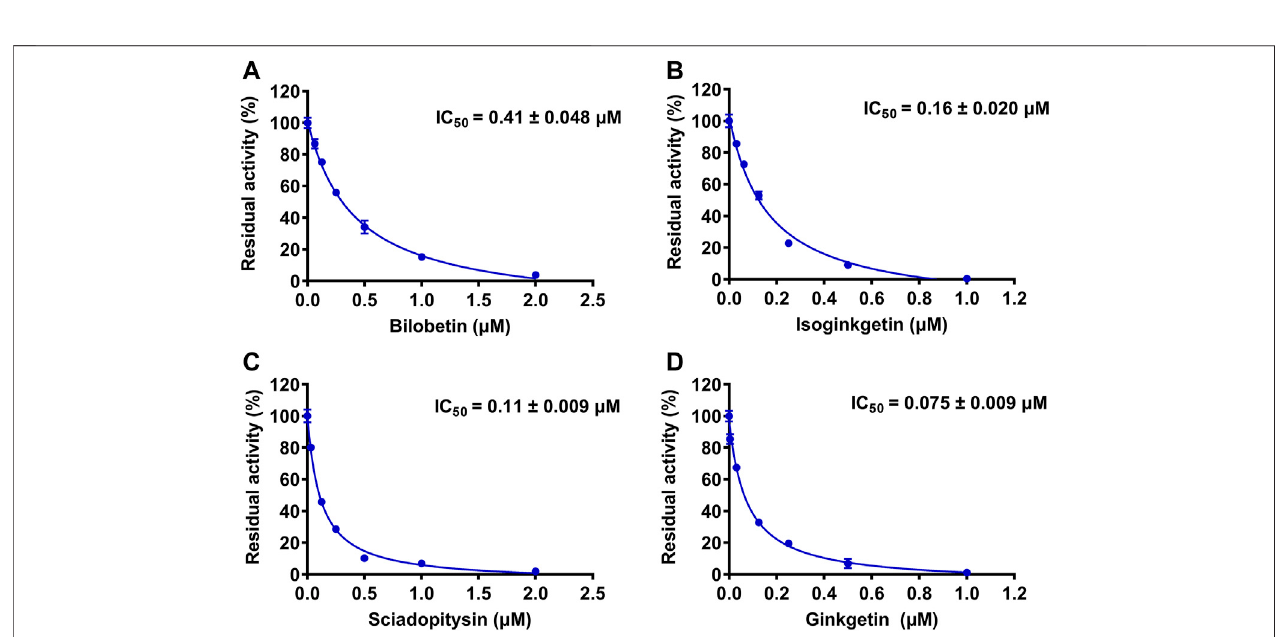
Frontiers in Pharmacology |